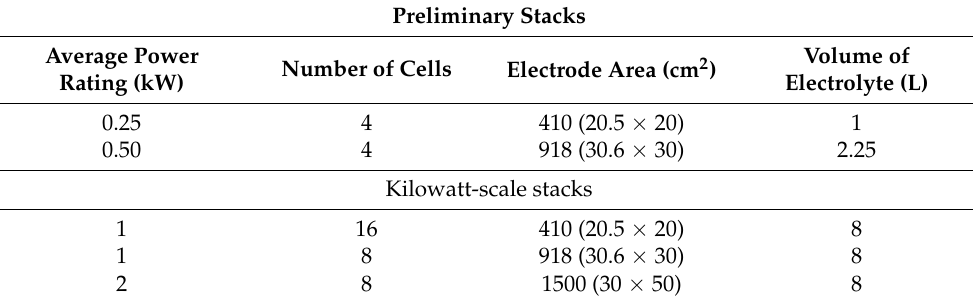
Table 2. Details of stacks